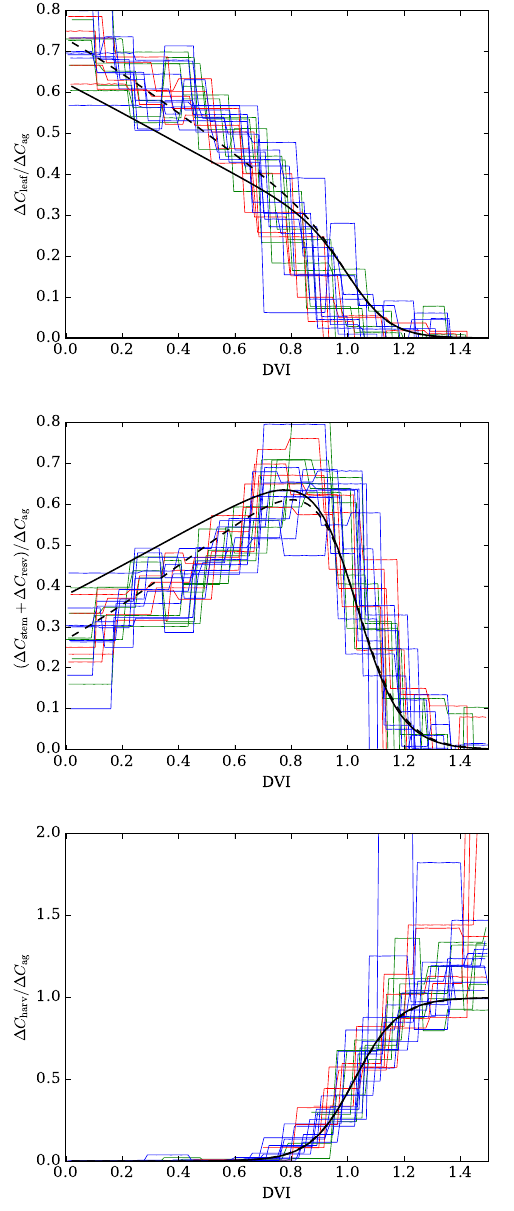
Figure 1. Top: ratio of rate of change of C leaf to rate of change of above-ground carbon C ag ; middle: ratio of rate of change of C stem + C resv to rate of change of above-ground carbon; bottom: ratio of rate of change of C harv to rate of change of above-ground carbon. Solid black line uses the original crop parameters from Osborne et al. (2015), dashed black line uses the tuned parameters. Blue, green and red lines are derived from US-Ne1, US-Ne2 and US-Ne3 observations respectively.